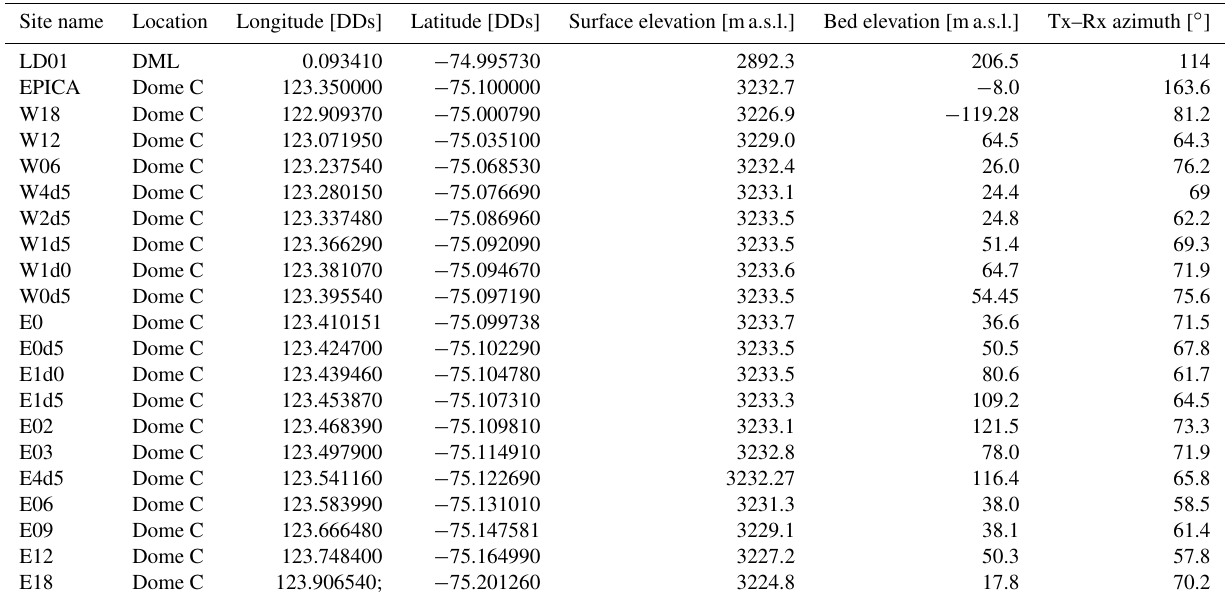
Table A1. ApRES stations info. Coordinates are shown in decimal degrees in the WGS84 reference system. Surface elevations are extracted from the Reference Elevation Model of Antarctica (REMA; Howat et al., 2019). Bed elevations are obtained from the polarimetric-radar data. Tx–Rx azimuth is measured by a compass with ± 15 ◦